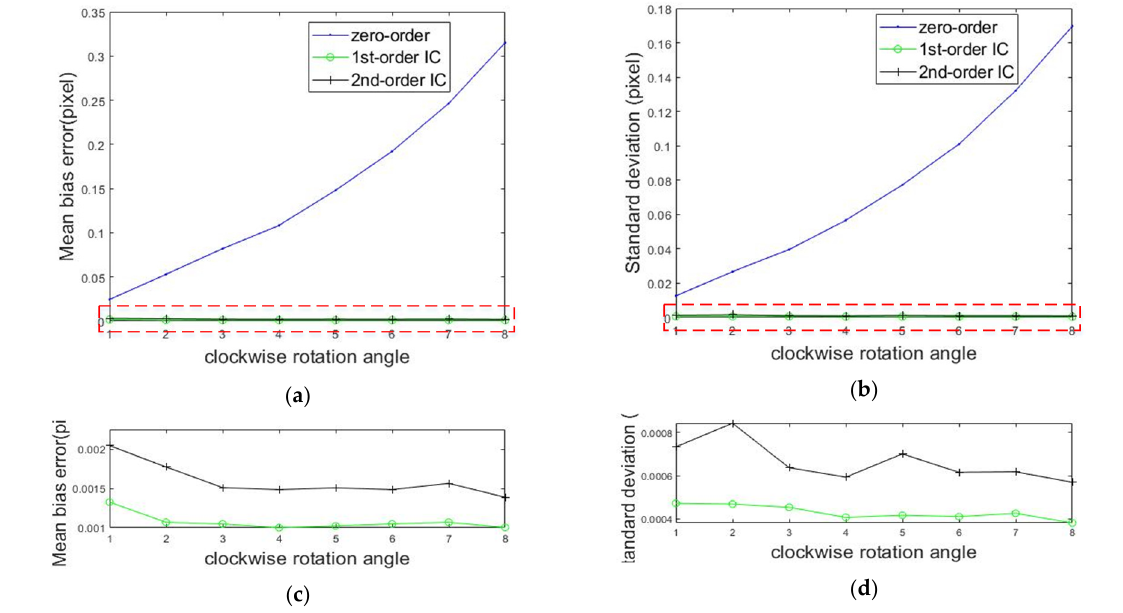
Figure 8. Calculated errors of the rigid body rotation compared to the set rotation angles. ( a ) Mean bias error; ( b ) standard deviation; and ( c,d ) enlarged views of the red dotted areas in ( a ) and ( b ), respectively.